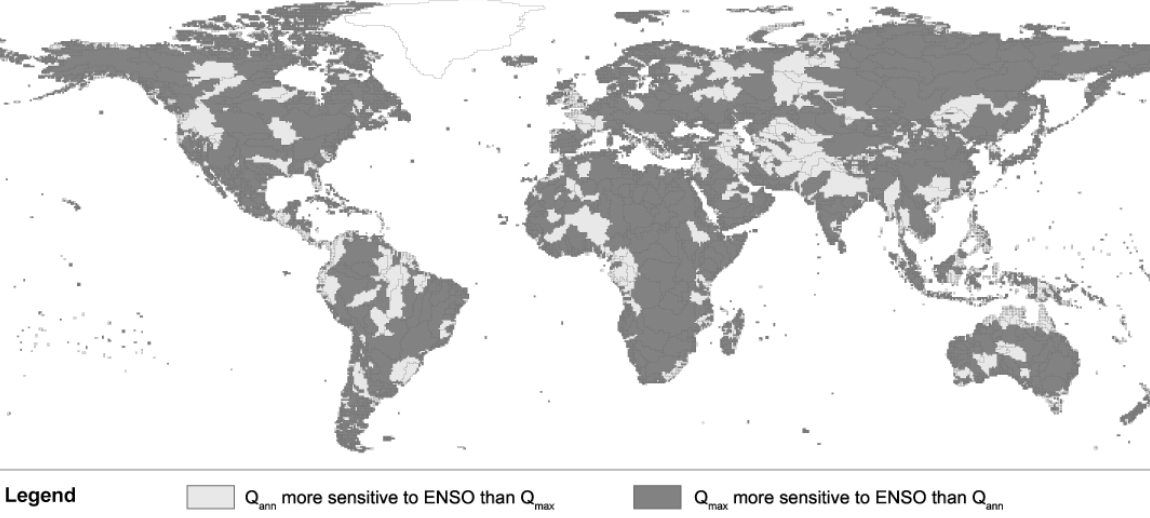
Fig. 5. Basins in which Q max ( Q ann ) is more sensitive than Q ann ( Q max ) to changes in SOI and vice versa. Table 2. Sensitivity of annual flood discharge to SOI*. Percentage change in Q max per unit change SOI (land area, %) Equatorial Arid Warm temperate Cold** All Köppen zones Australia and Oceania 36% (43%) Central America